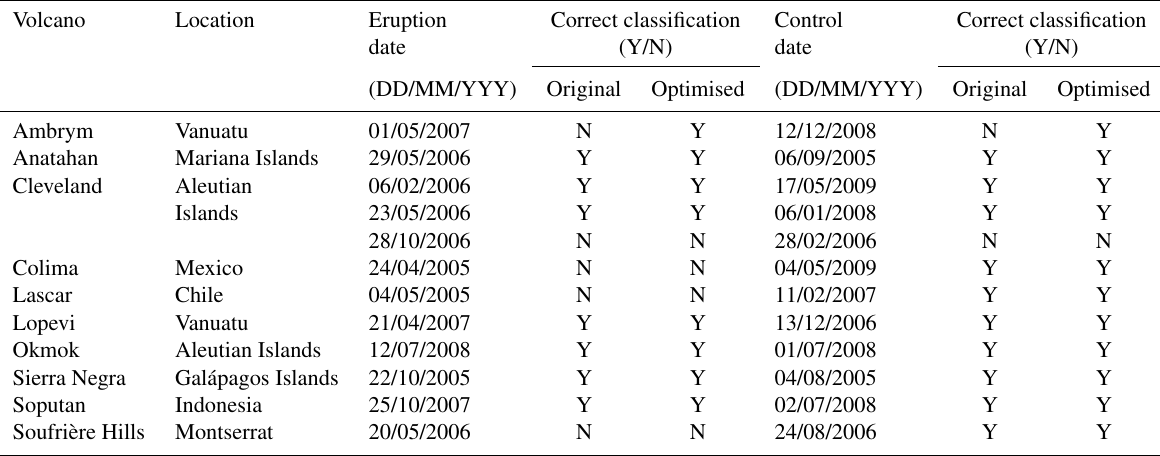
Table 5. Locations and dates of volcanic and control “eruptions” for validation dataset.